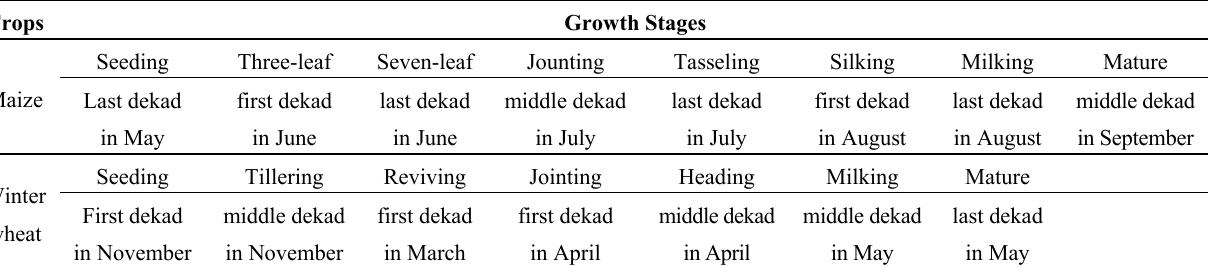
Table 1. Maize and winter wheat growth stages in a